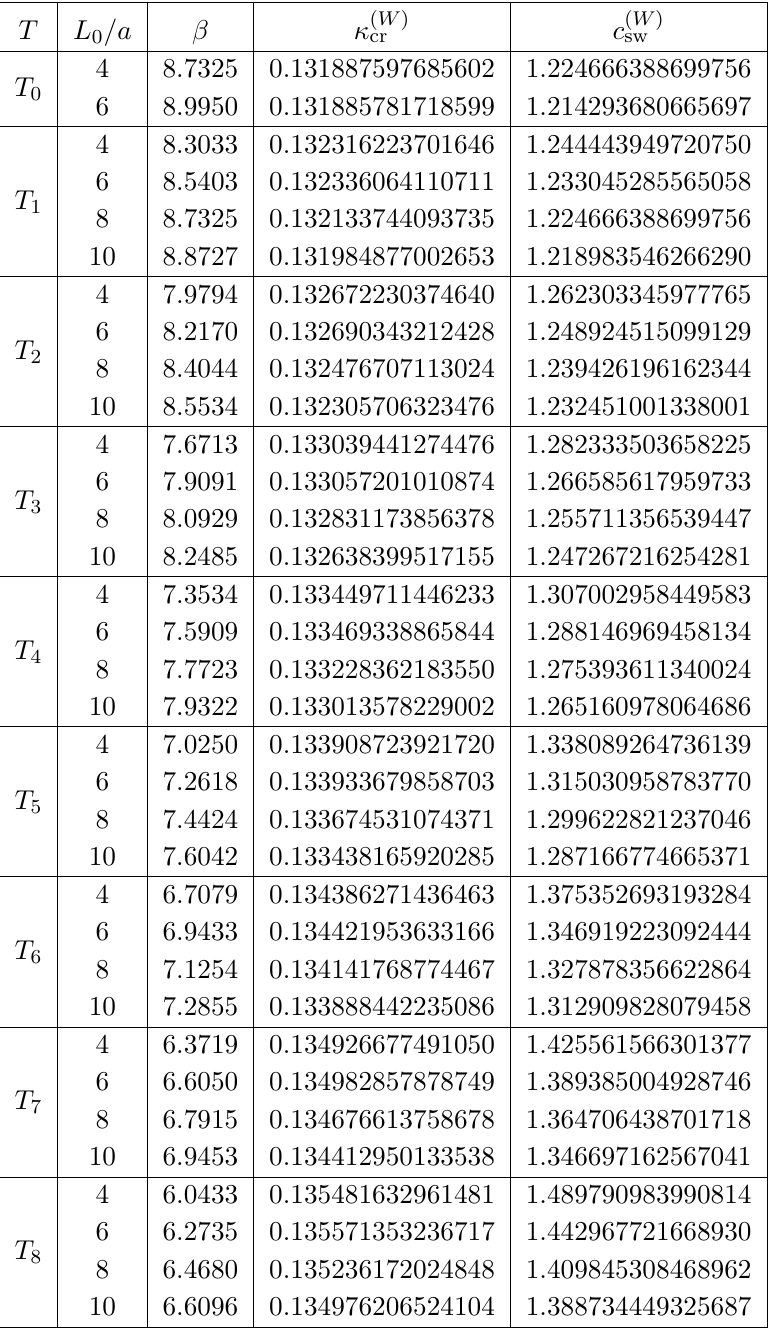
Table 4 . Parameters of the Monte Carlo simulations performed with the Wilson plaquette action. The bare gauge coupling is expressed in terms of β = 6 /g 2